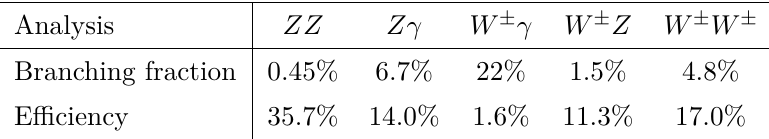
/f a , c /f a ) plane using the data of the e W e B < 4 TeV . The limits have been calculated 1 V 2